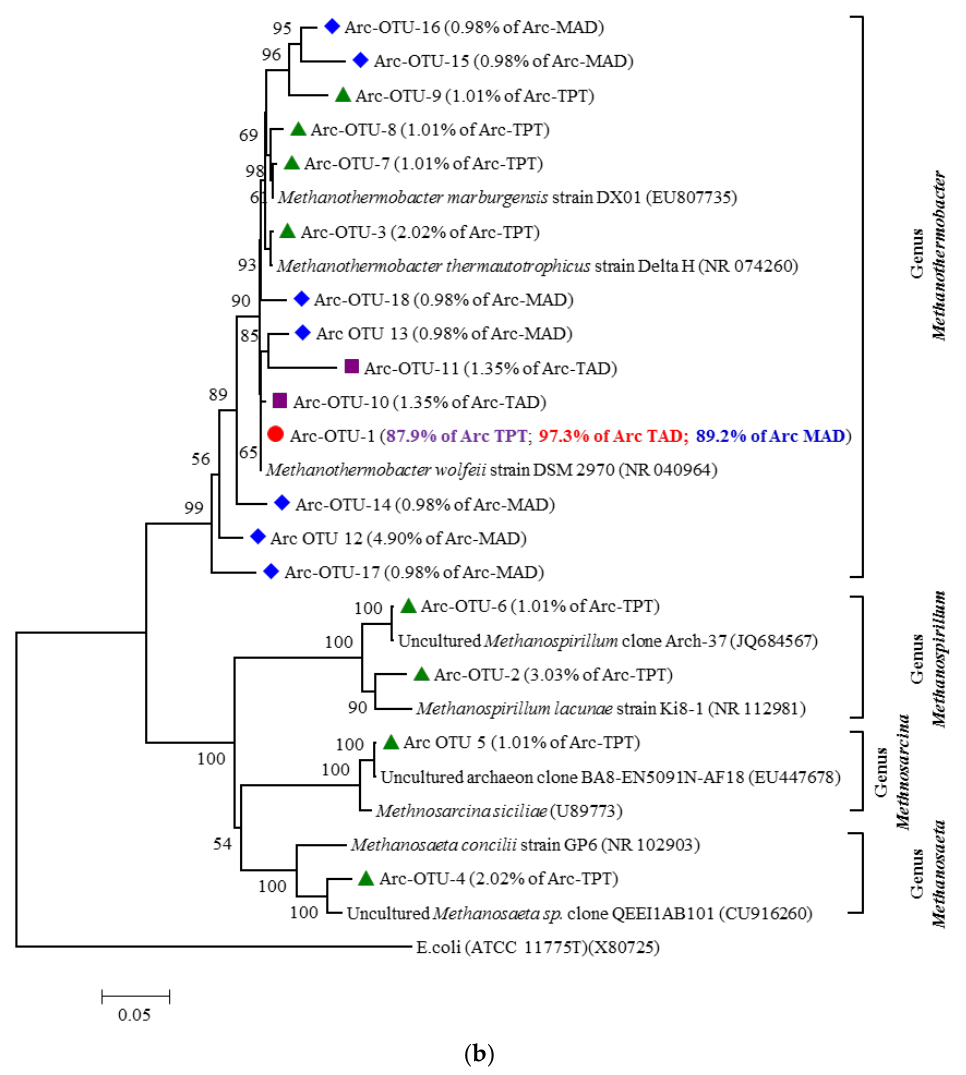
Figure 3. Neighbour-joining phylogenetic trees of ( a ) bacterial and ( b ) archaeal communities.